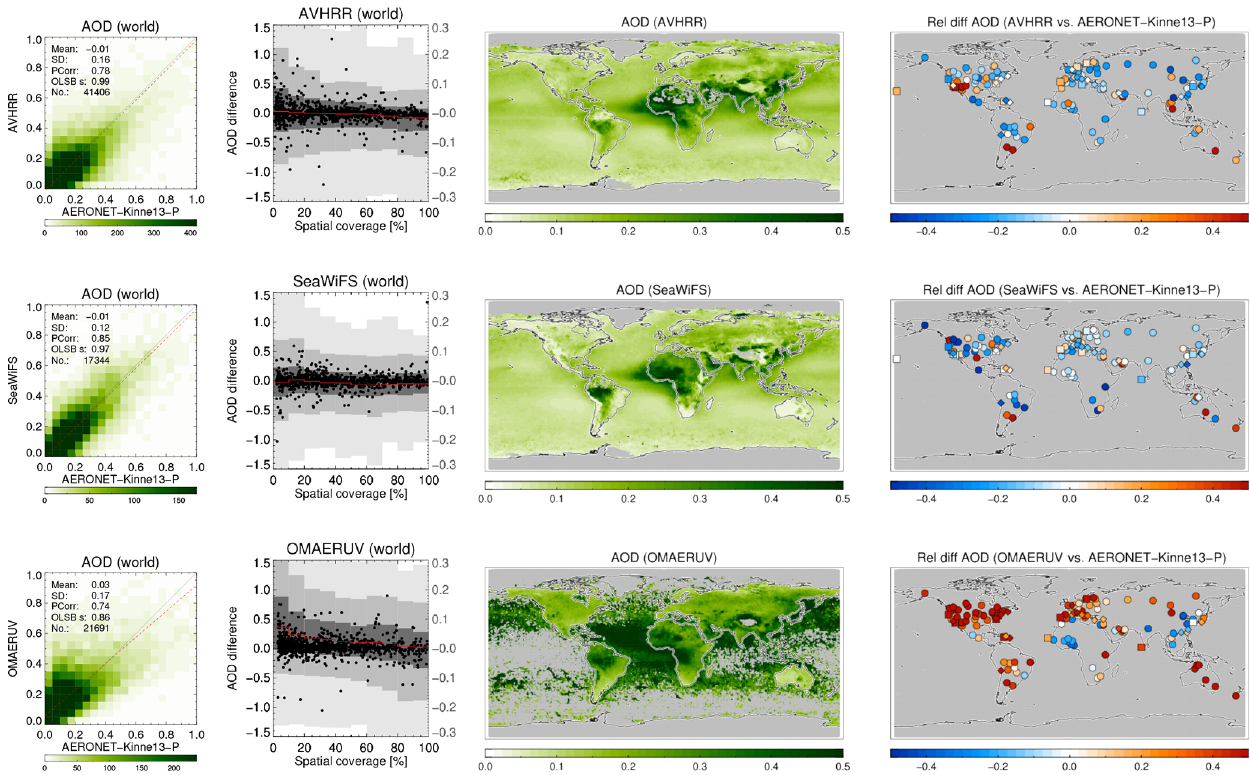
Figure 10. Same as Fig. 9, for AVHRR, SeaWiFS and OMAERUV products.